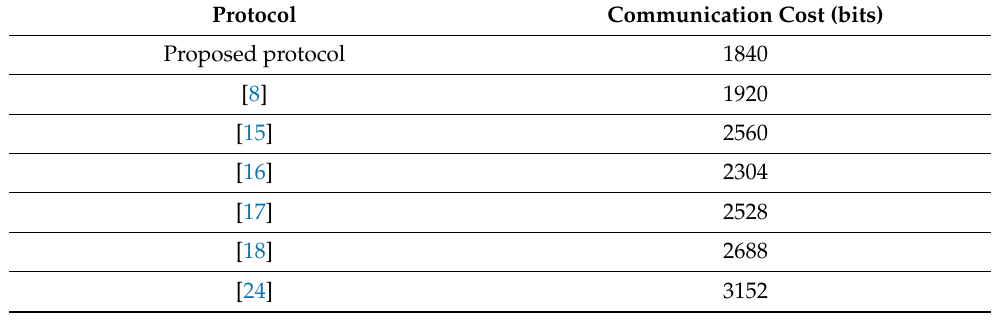
Table 2. Communication cost.